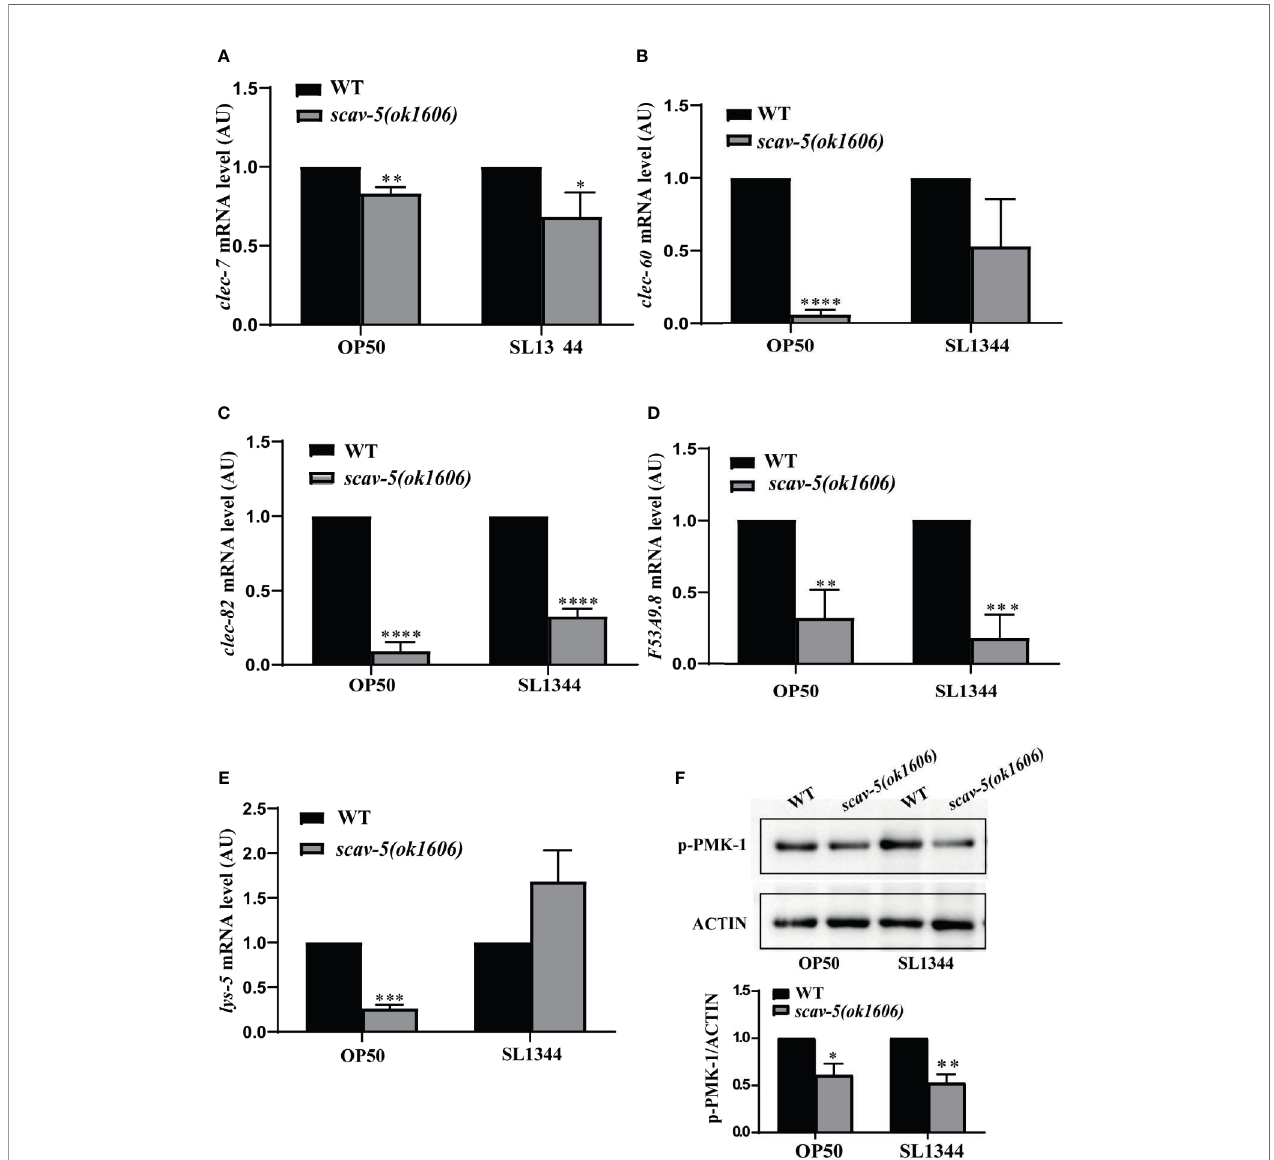
FIGURE 4 | The innate immune response in scav-5 mutants fed on E. coli OP50 or S. typhimurium SL1344 were downregulated. (A) Immunoblot analysis of p-PMK-1 in young adult animals of wild type and scav-5(ok1606) mutants fed on E. coli OP50 or S. typhimurium SL1344 for 48h. (B – F) qRT-PCR analysis of transcription level of pathogenic response genes clec-7 , clec-60 , and clec-82 (B – D) , lys-5 (E) , and F53A9.8 (F) in wild-type and scav-5(ok1606) animals cultured on E. coli OP50 or S. typhimurium